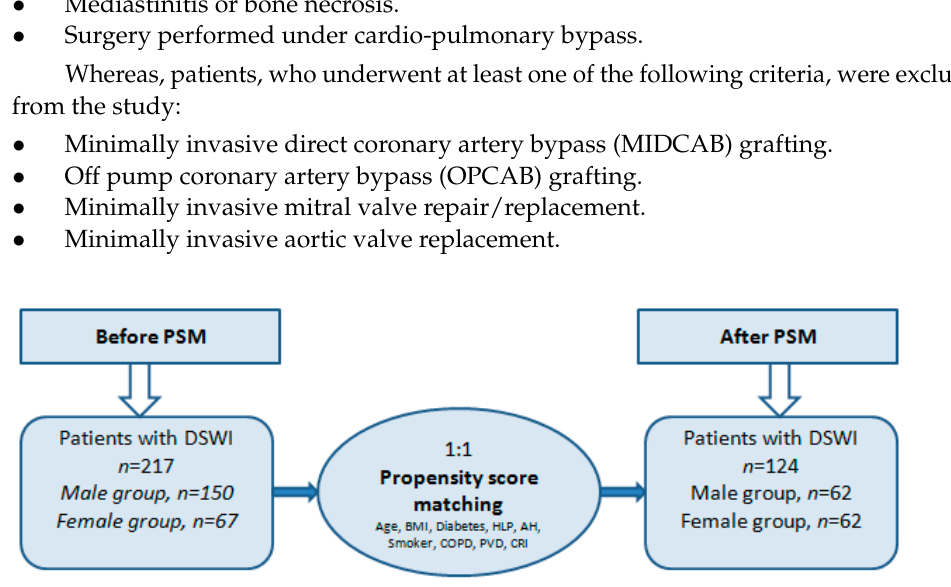
Figure 1. Sample distribution with DSWI before and after PSM. PSM, propensity score matching; DSWI, deep sternal wound infection; BMI, body mass index; HLP, Hyperlipidaemia; AH, arterial hypertension; COPD, chronic obstructive pulmonary disease; PVD, peripheral vascular disease; CRI, chronic renal insufficiency.